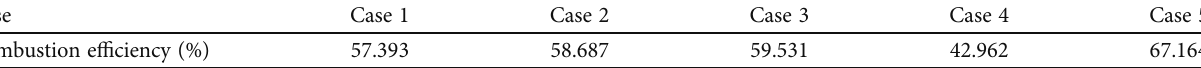
Table 5: Combustion e ffi ciency at the exit of the